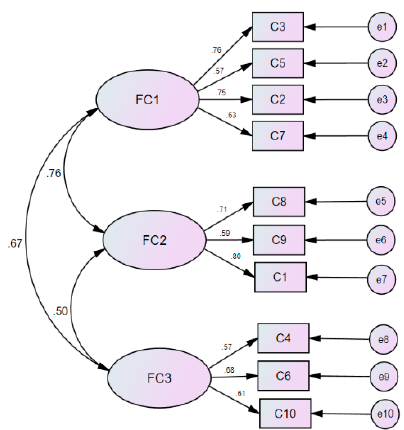
Figure A6. The 3-scale structure model graph yielded by the CFA of the indicator of “writer’s experience” (FC1: affective or cognitive experience; FC2: sensory experience; FC3: social-identity experience or behavior). Table A10. Structure-model fit indices of the indicator of “writer’s experience” yielded by the CFA process a.